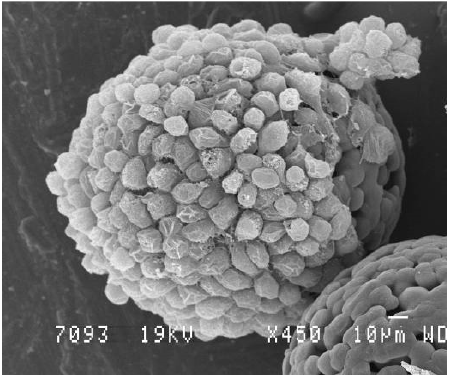
Figure 4. SEM micrography of degradable microparticles covered with fibroblasts L929 5 days after in vitro cell culture in DMEM medium at 37 °C. The surface of the microcarriers have been tailored to be rugous in order to promote cell adhesion. SEM image of the microparticles was made by au-